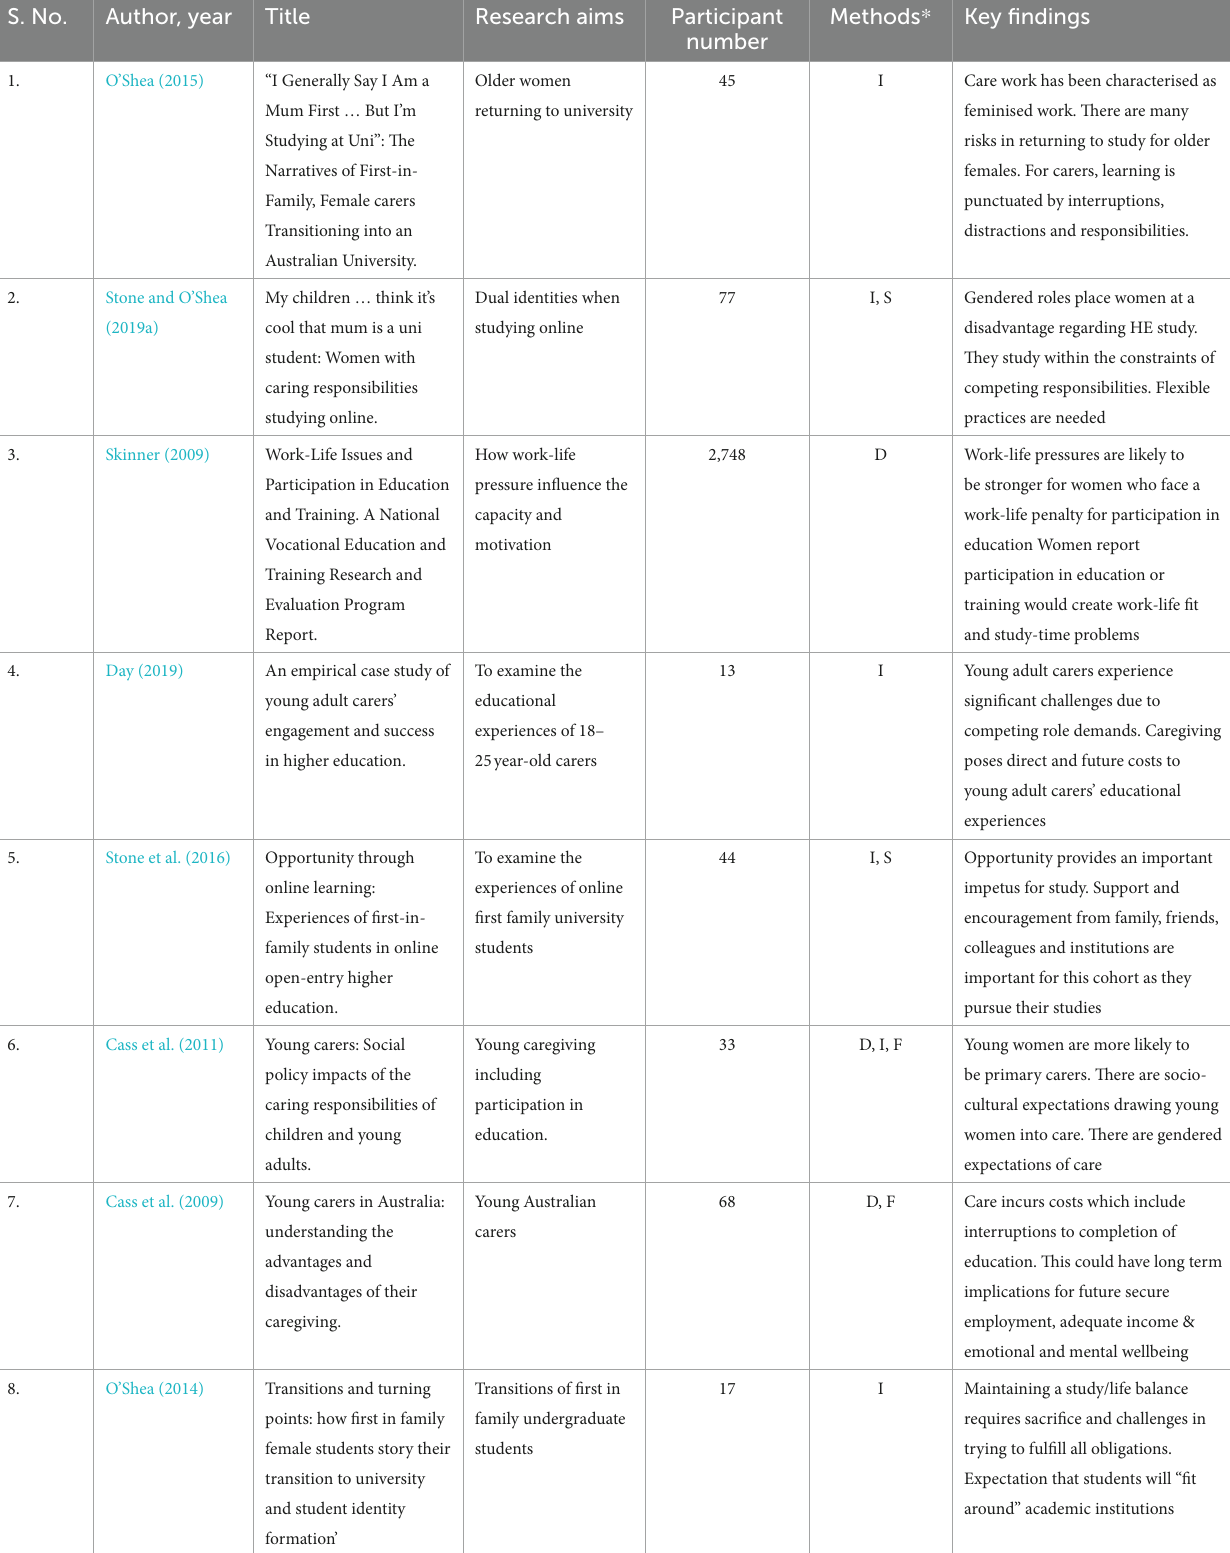
TABLE 2 Summary of included Australian